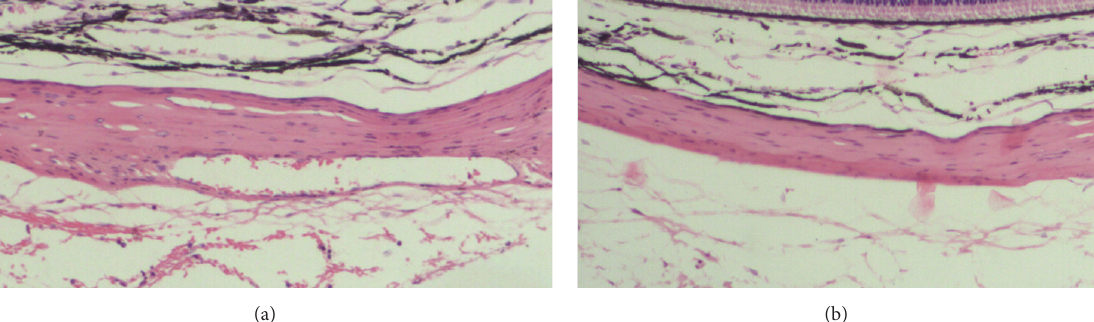
Figure 5: The Tenon capsule of the FDMG eye and the control eye. (a) The Tenon capsule in drug depot area of the FDMG eye became compact and adhered to the sclera tightly (H&E stain; original magnification -100). (b) The Tenon capsule was loose in the control eye (H&E stain; original magnification -100).